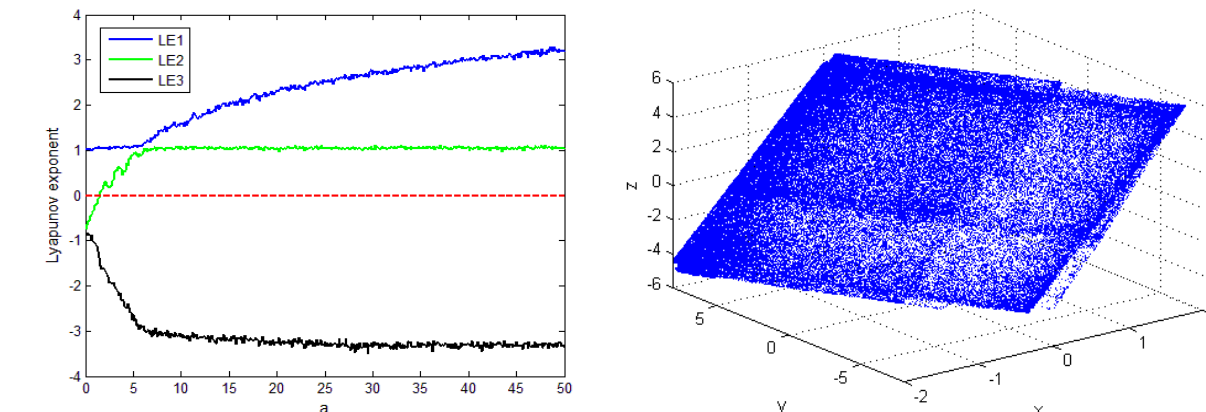
Fig 2. (a) Lyapunov exponent diagram versus parameter a, (b) Spatiotemporal diagram with initial